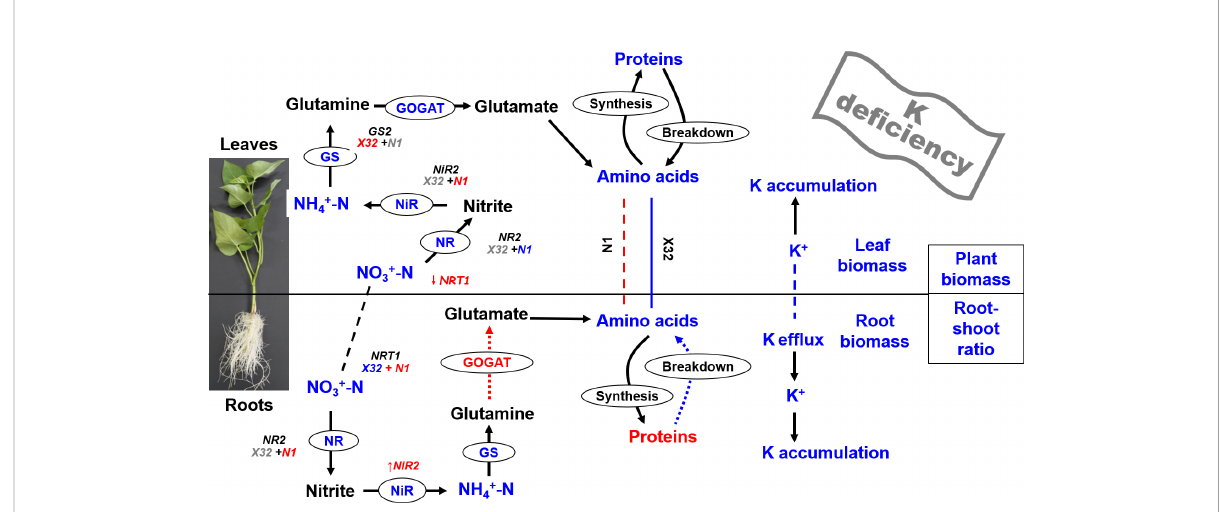
FIGURE 10 Scheme summarizing the effects of K de fi ciency on primary metabolism in leaves and roots of sweet potato. Biochemical and transport pathways are indicated with solid and dashed arrows, respectively. Increases in metabolite concentrations and enzyme activities under K de fi ciency are shown in red, decreases are shown in blue, and items that do not change signi fi cantly under K de fi ciency are marked with gray. Putative direct inhibition under K de fi ciency is indicated with the red bar. Dashed lines indicate the exchange of metabolites between leaves and roots. X32 and N1 represent Xushu 32 and Ningzishu 1,